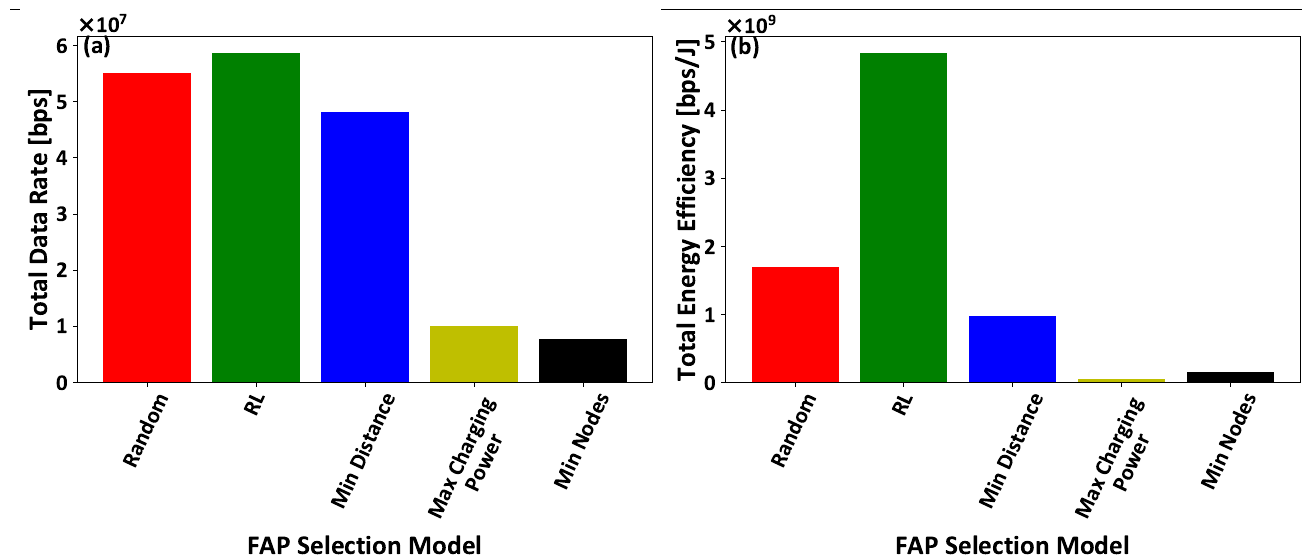
Figure 9. ( a ) Total achieved data rate and ( b ) energy efficiency of all the IoT nodes — A Comparative